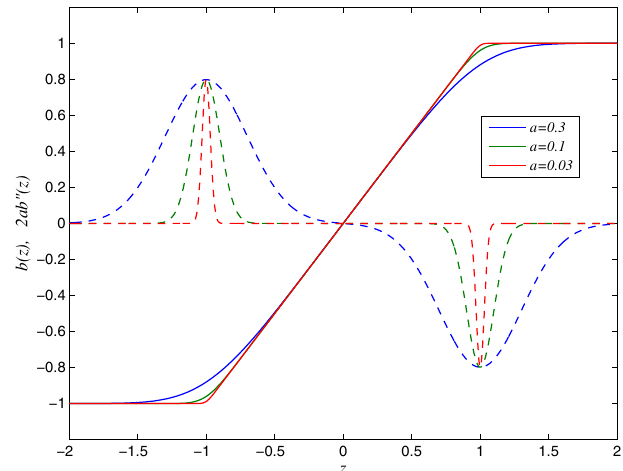
FIG. 1. (Color) b (cid:2) z (cid:3) (solid) and 2 ab 00 (cid:2) z (cid:3) (dash) for a (cid:6) 0 : 3 , 0.1, and